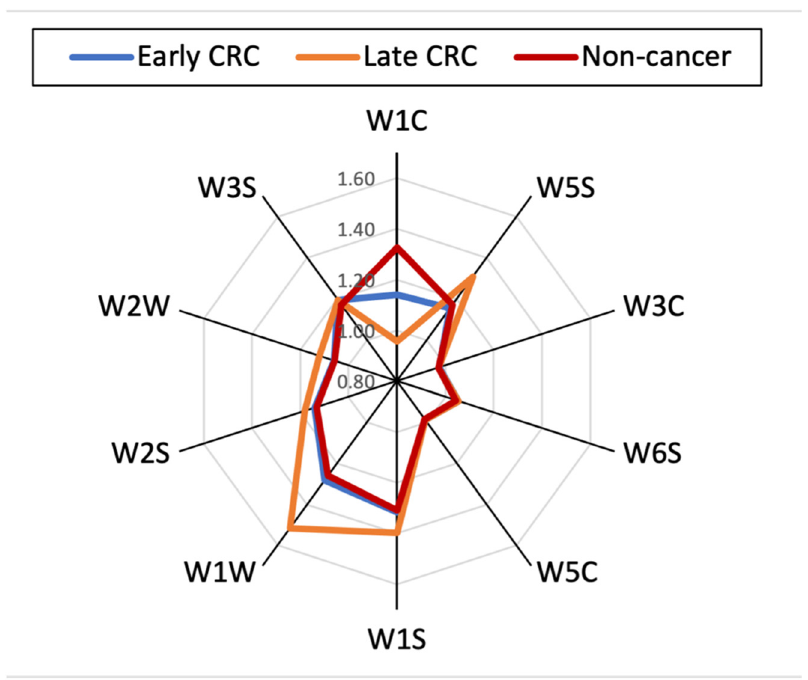
Figure 4. Radar plot of the output features of the PEN3 to an early-stage CRC, late-stage CRC, and control sample.